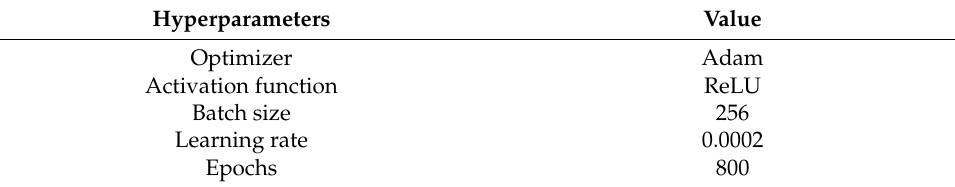
( b ) Figure 5. Accuracy ( a ) and loss ( b ) curves of the model on the selected parameters.